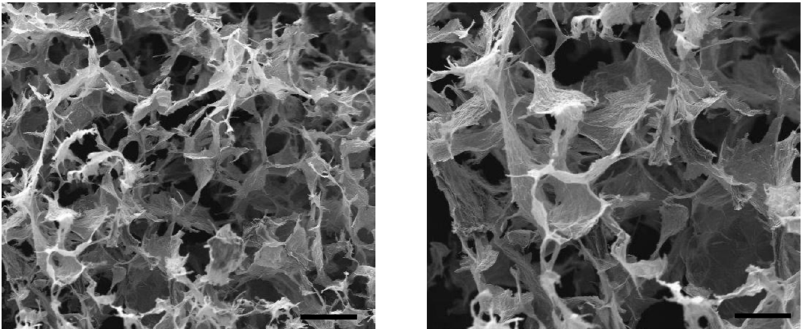
Figure 2. SEM images of the chitosan-graphene oxide composite aerogels. Scale bars: 100 µ m for the figure on the left , 10 µ m for the figure on the right